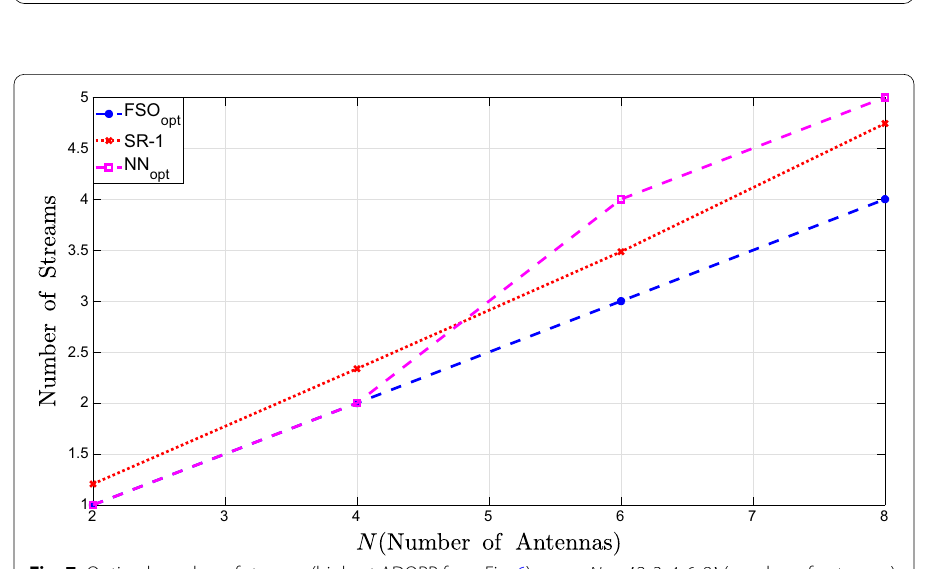
Fig. 7 Optimal number of streams (highest ADORP from Fig. 6) versus N = { 2,3,4,6,8 } (number of antennas) for a system with p tx = 0.25, π r 2 RZ = 10 and α = 2.7 . The figure depicts the curves of the SR-1 scheme, the optimal FSO scheme ( FSO opt ) and the optimal NN scheme ( NN opt